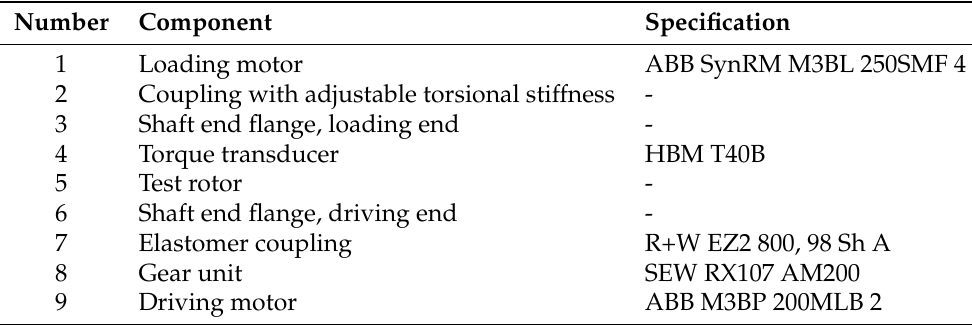
Figure 1. Powertrain setup. The components are presented in Table 1. Table 1. The components in the